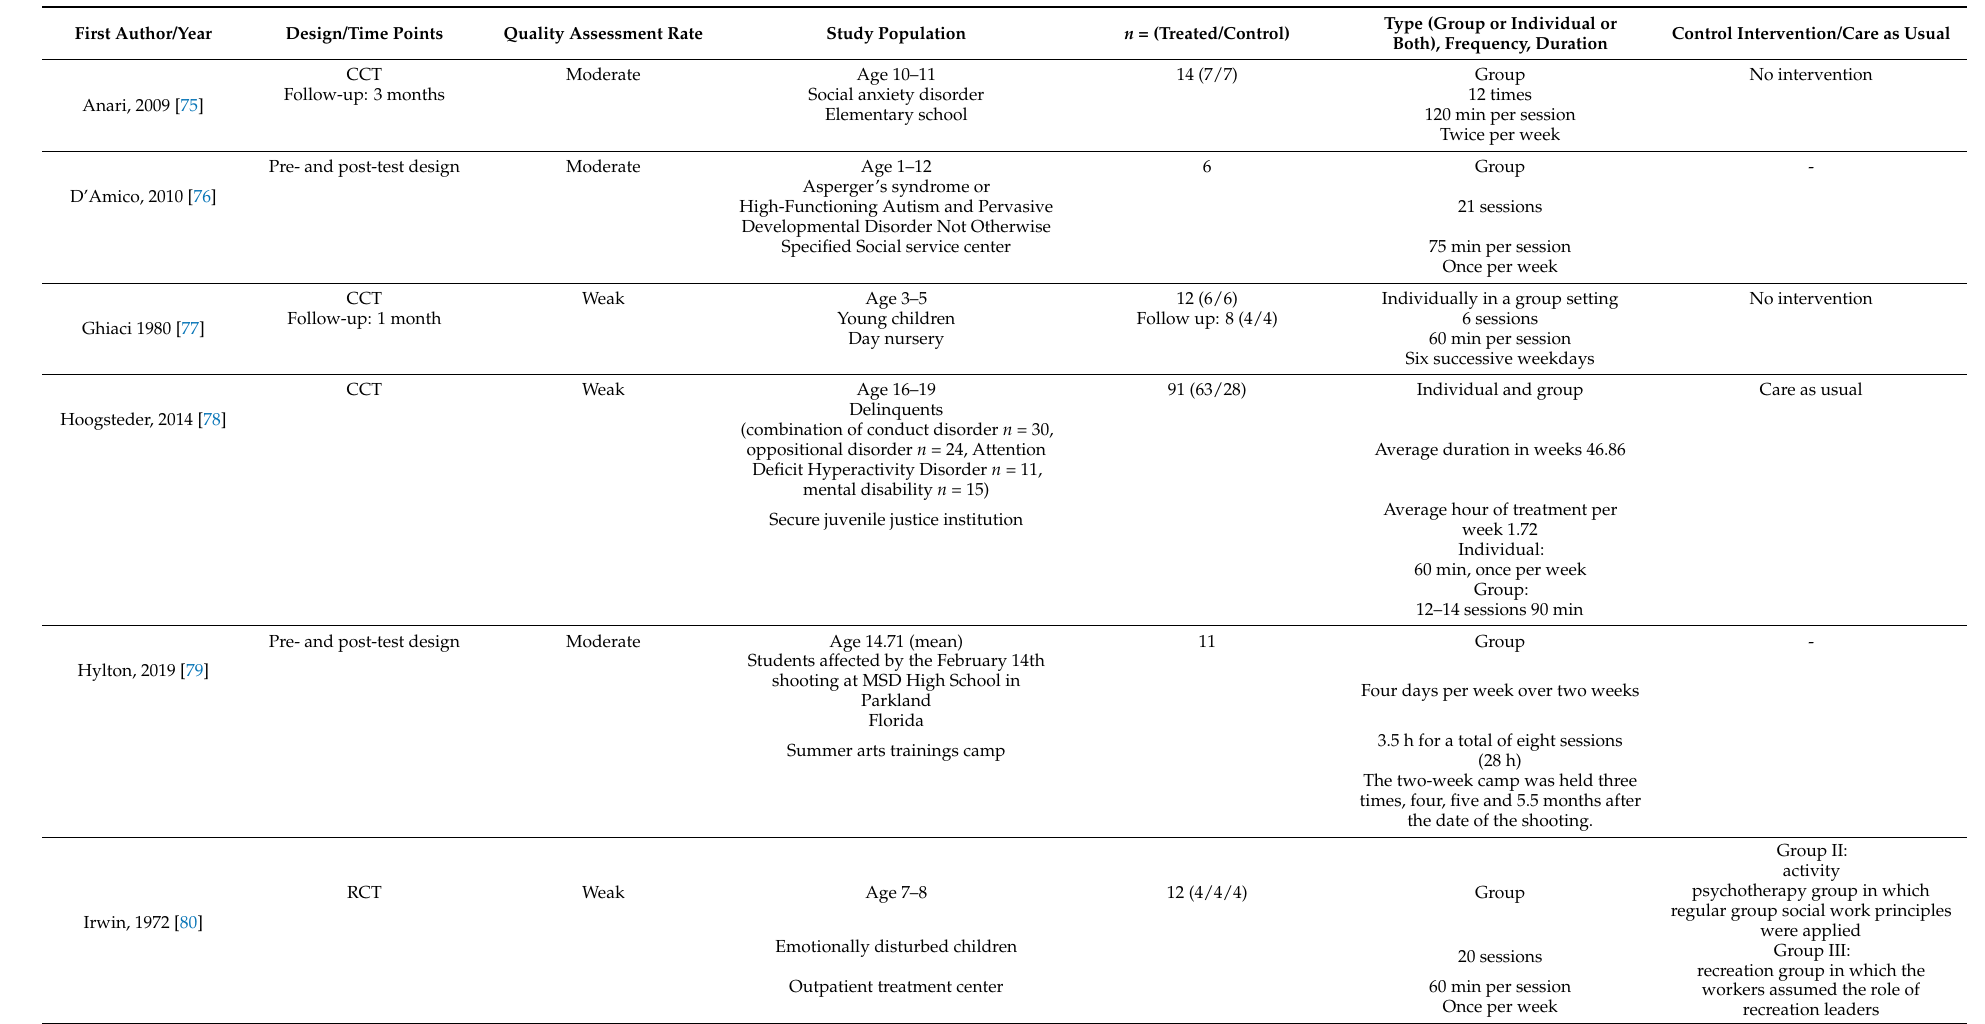
Table 1. Formal characteristics of included